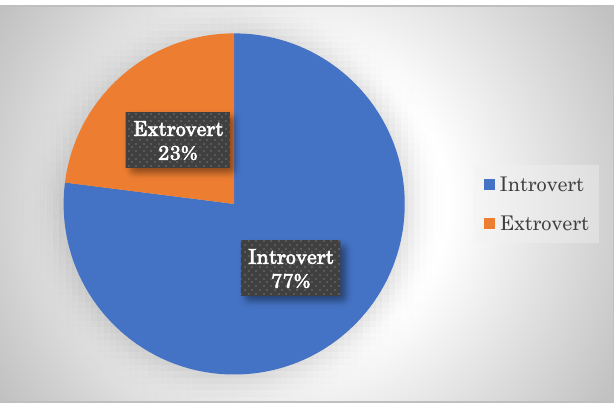
Fig. 2. Distribution of class A in a dataset